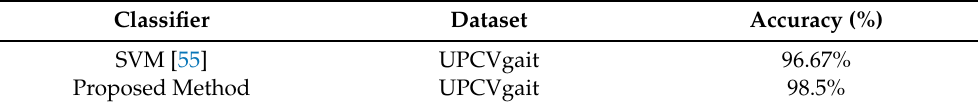
Table 9. Comparison of classification accuracy between the proposed system and the conventional